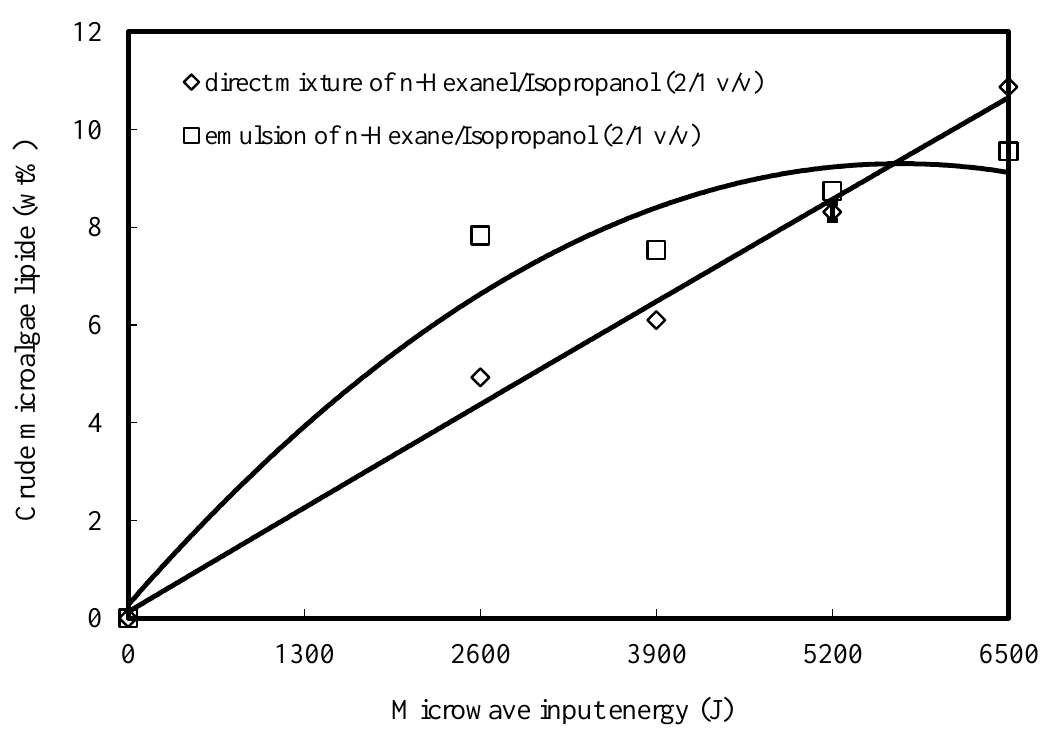
Figure 6. Comparison of the crude microalgae lipid quantities extracted by the microwave-assisted method with an emulsion solvent and a direct solvent mixture under various input